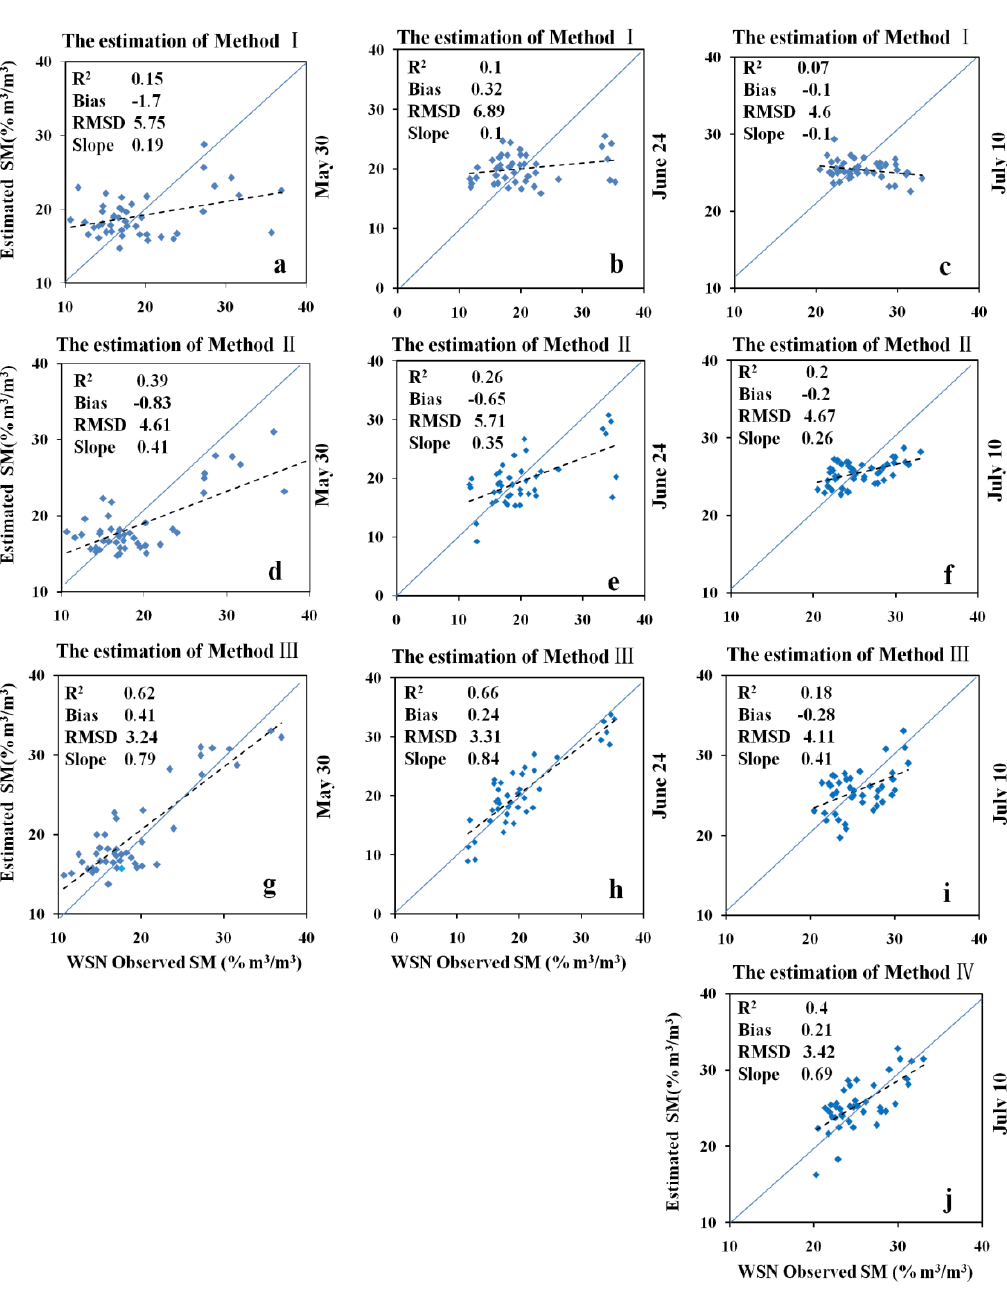
Figure 9. Cross-validation and accuracy statistics of the results from the four methods. ( a – c ), ( d – f ), ( g – i ), j are the validation of predictions from method I, II, III and IV for three periods, respectively. Units for RMSD and Bias are